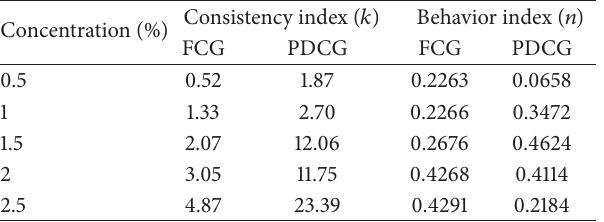
Table 2: Consistency and behavior index of fatted and partly defatted chia